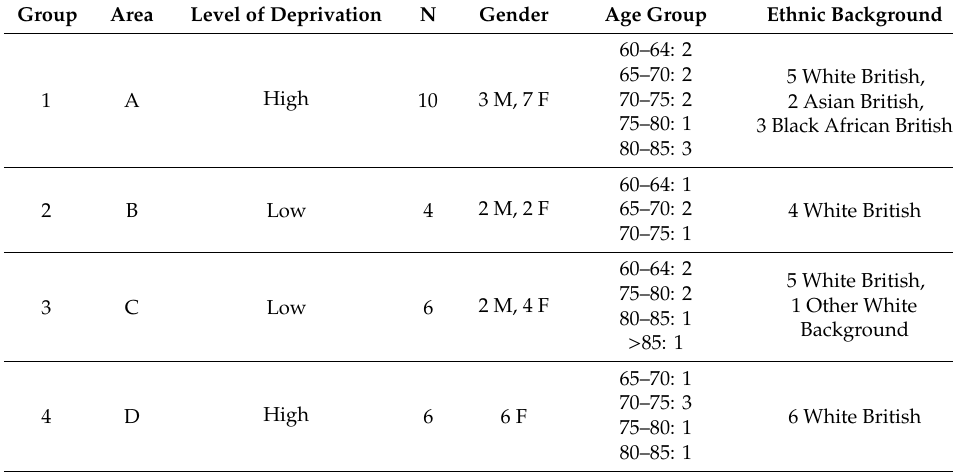
Table 3. Study participants. M = male, F =